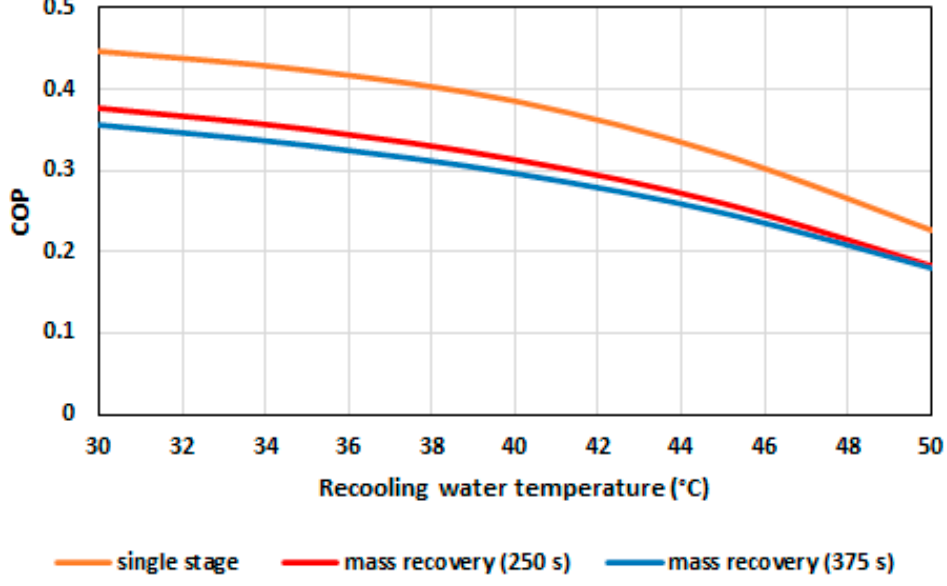
Figure 16. Predicted COP with various cycle stages and recooling water temperatures. The cycle time has a significant effect on cooling capacity and COP. Therefore, the variable mode cycle was simulated using the model at different cycle times and with value in a comparable manner. The following four modes were investigated in this